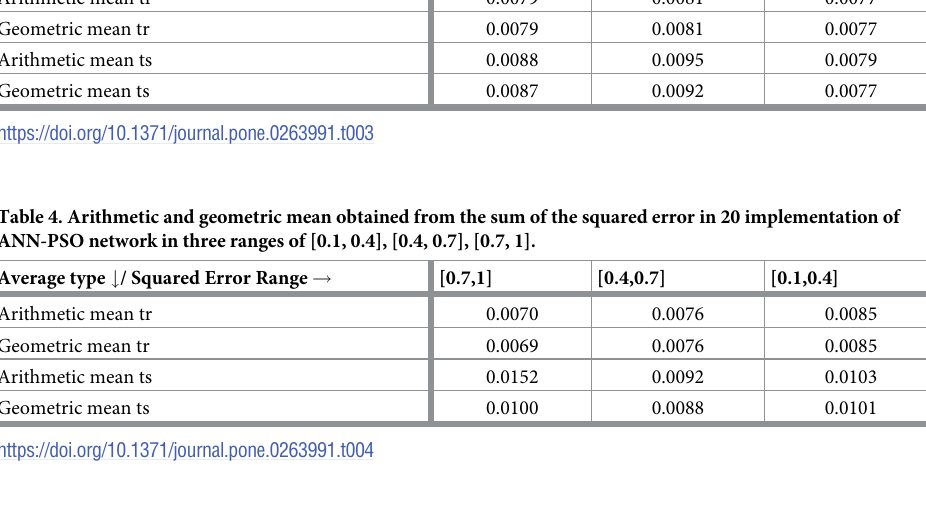
Table 5. Total mean square error (MSE) of training and experimental data in the best implementation of ANN-BTA network for estimating basic reproduction number related to COVID-19 patients in the ranges of